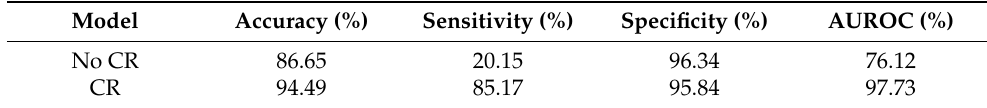
Table 6. Performance of the GBC model trained without CR and trained only with